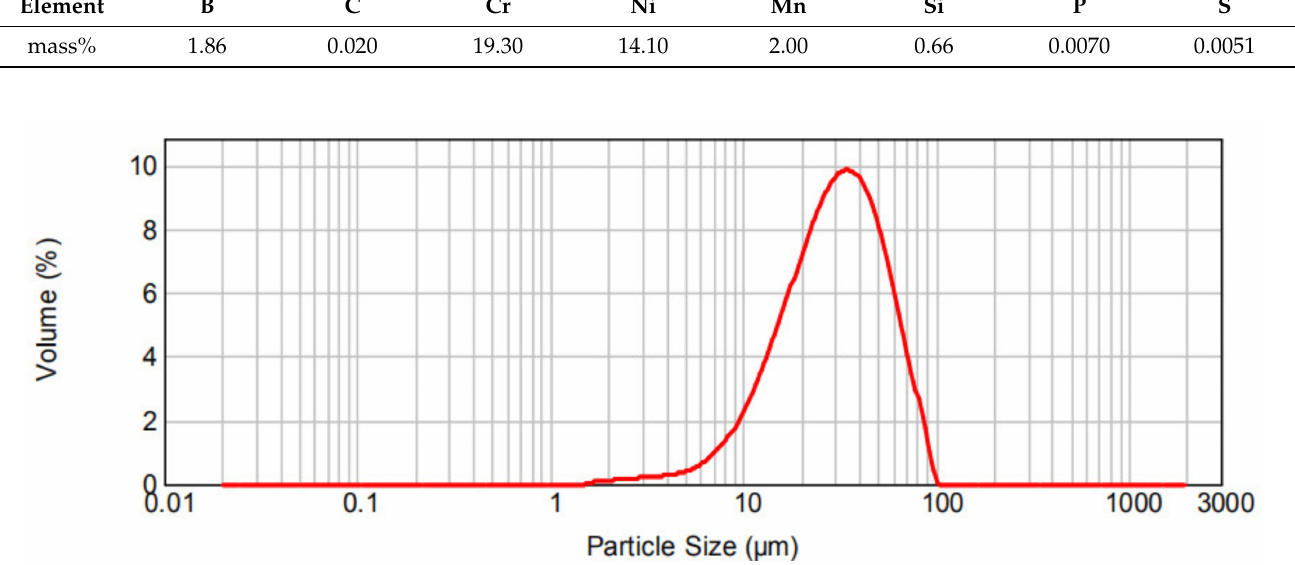
Figure 3. Powder particle size